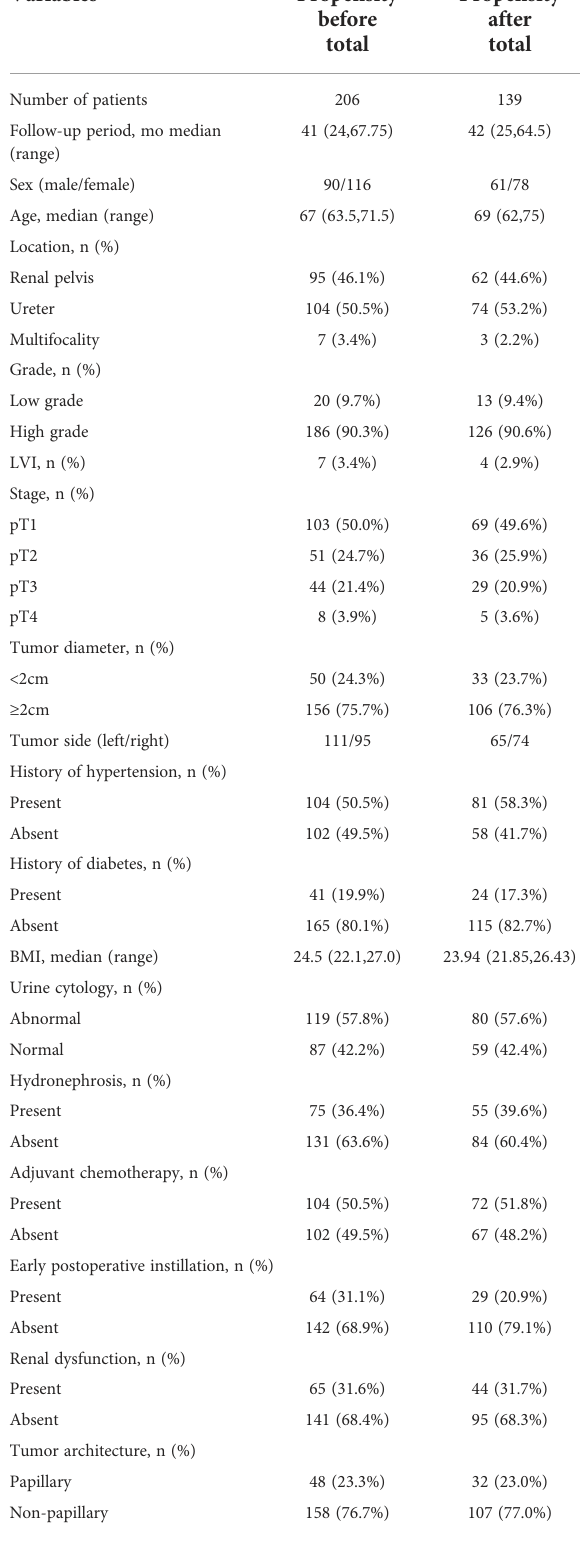
TABLE 1 Demographic and clinicopathological characteristics of patients with